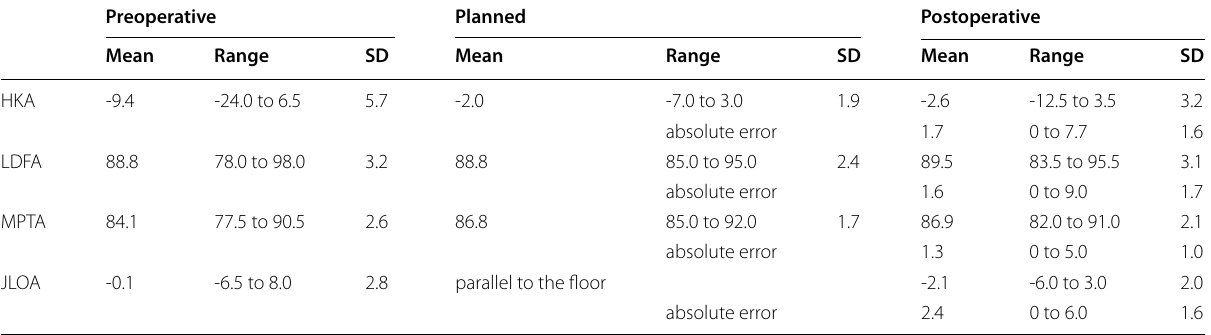
tibial angle, SD Standard deviation